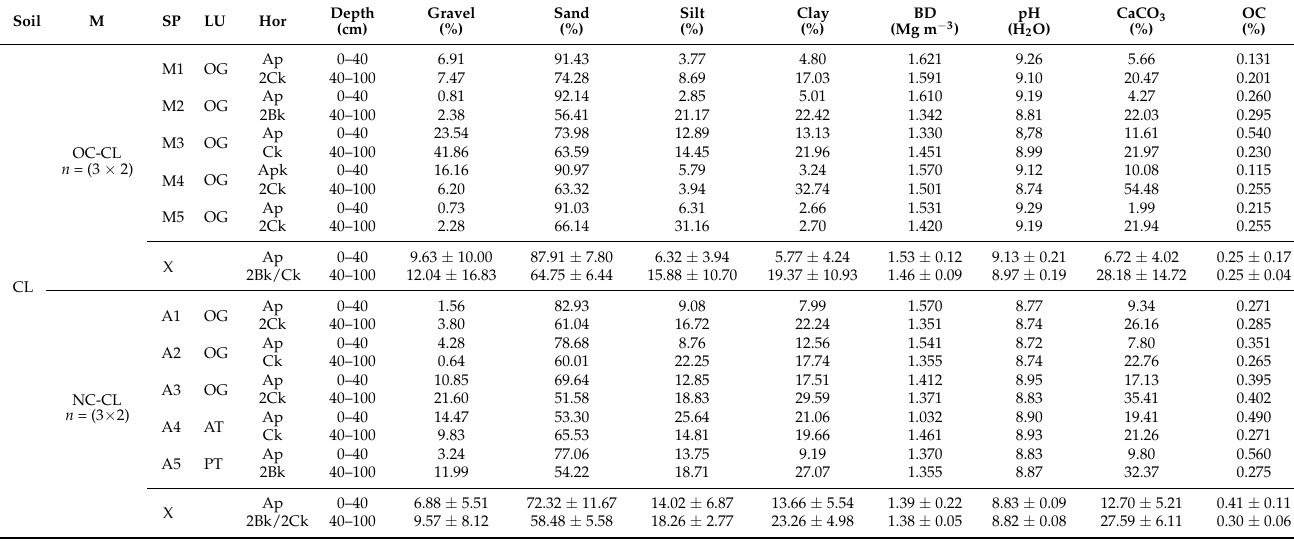
Table 5. Principal soil properties evaluated (average ± SD *) in the soil profile by soil control section in Calcisol.